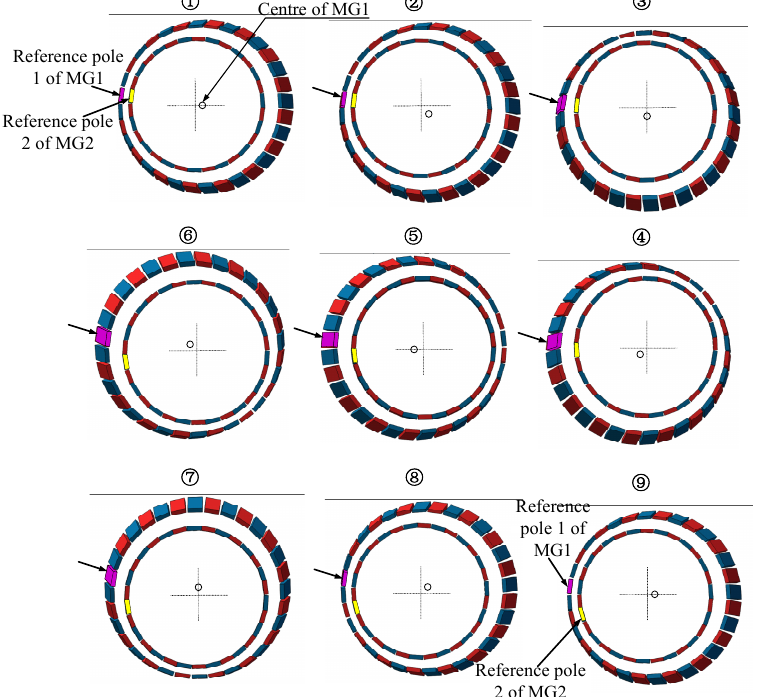
Figure 3. Principle of gear movement with the input shaft rotated a circle.